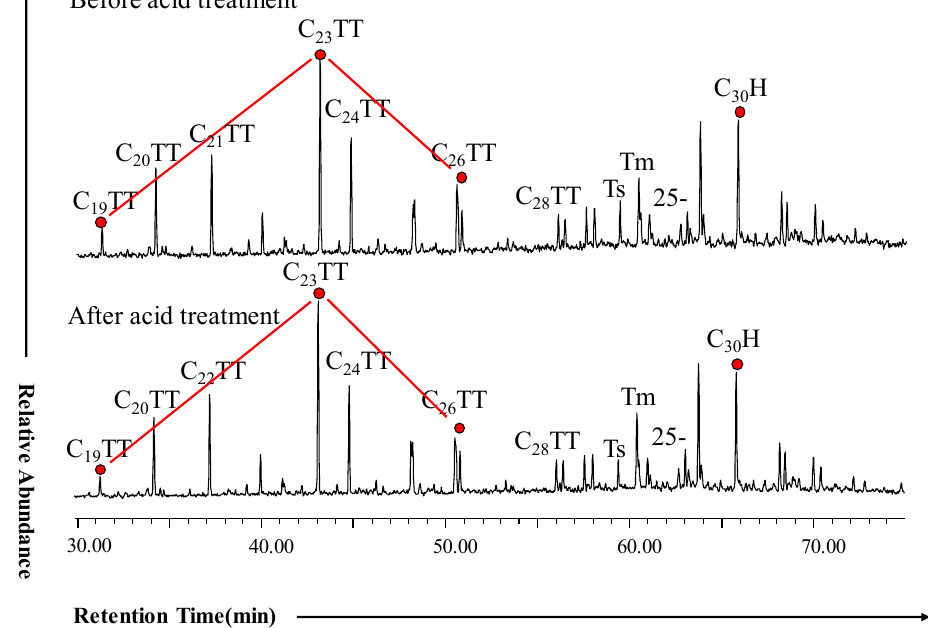
Figure 8. Saturated hydrocarbon fraction m / z 191 mass chromatogram of oil stains in the wellhead blockage before and after acidification of Well DH231 . Table 3. Geochemical parameters of Ordovician crude oil and wellhead blockage.